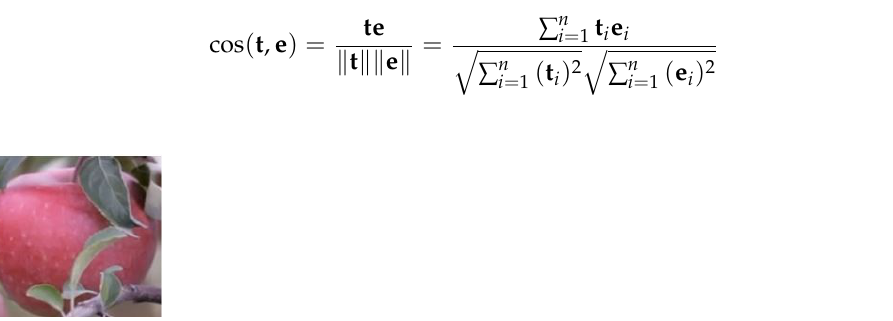
Figure 5. First apple detected in first frame and is inserted into the tracker which identifies it as track 1.